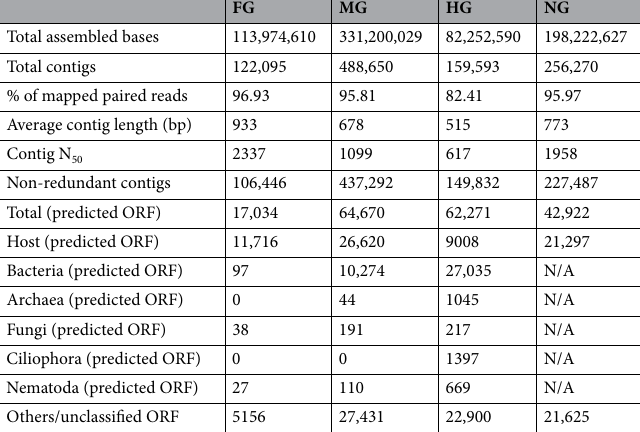
Table 1. De novo transcriptome assembly statistics, contig N 50 number, non-redundant contig number, and predicted ORFs in the different gut and non-gut tissues in the T. aoutii . N/A not